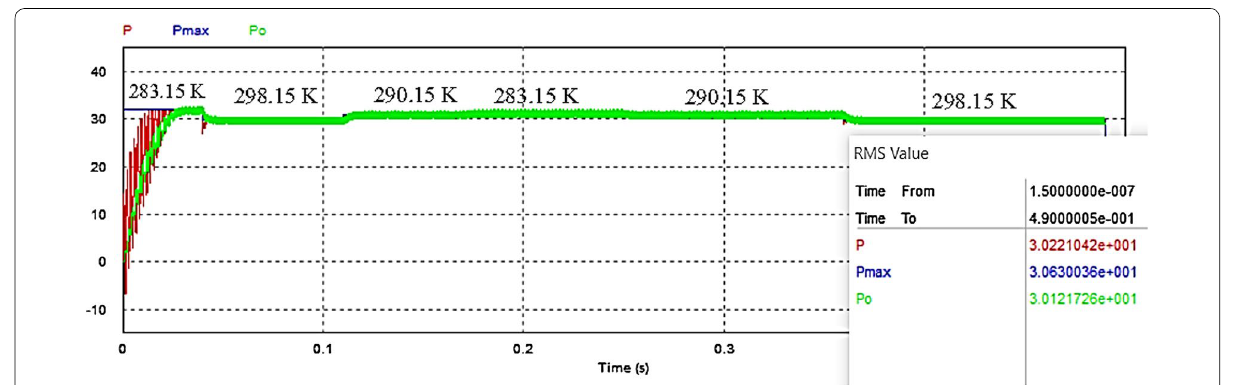
Fig. 14 Output powers for INC algorithm under variable temperature